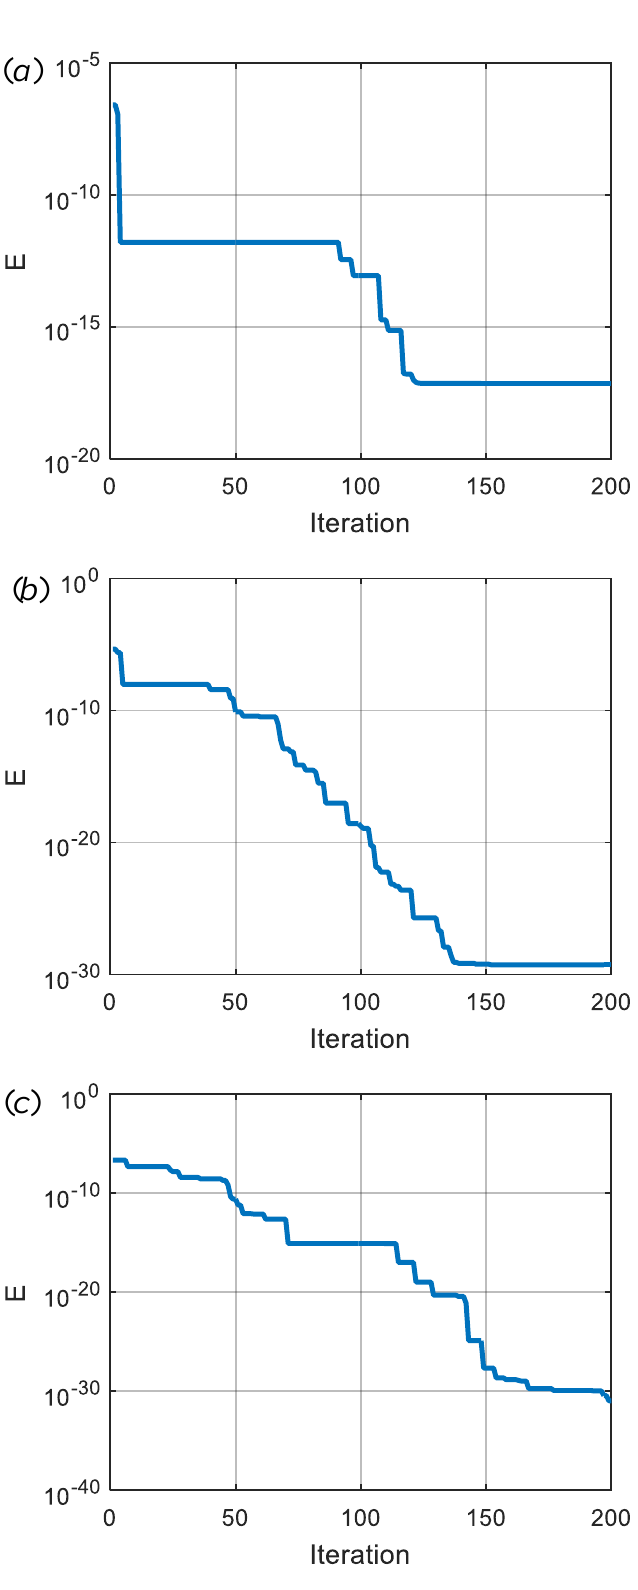
= 4 π , ( b ) for φ T 2 = 3 π and ( c ) for φ T 3 = 7 π . Figure 9. Changes of SAEs ( a ) for Figure 9. Changes of SAEs ( a ) for φ T 1 60 80 40 Figure 10a–c show the placements of all roots of characteristic polynomials from the interval uncertainty box (characteristic roots are indicated by red asterisks and dots). The figures reveal that the minimum argument root of the interval system was placed on